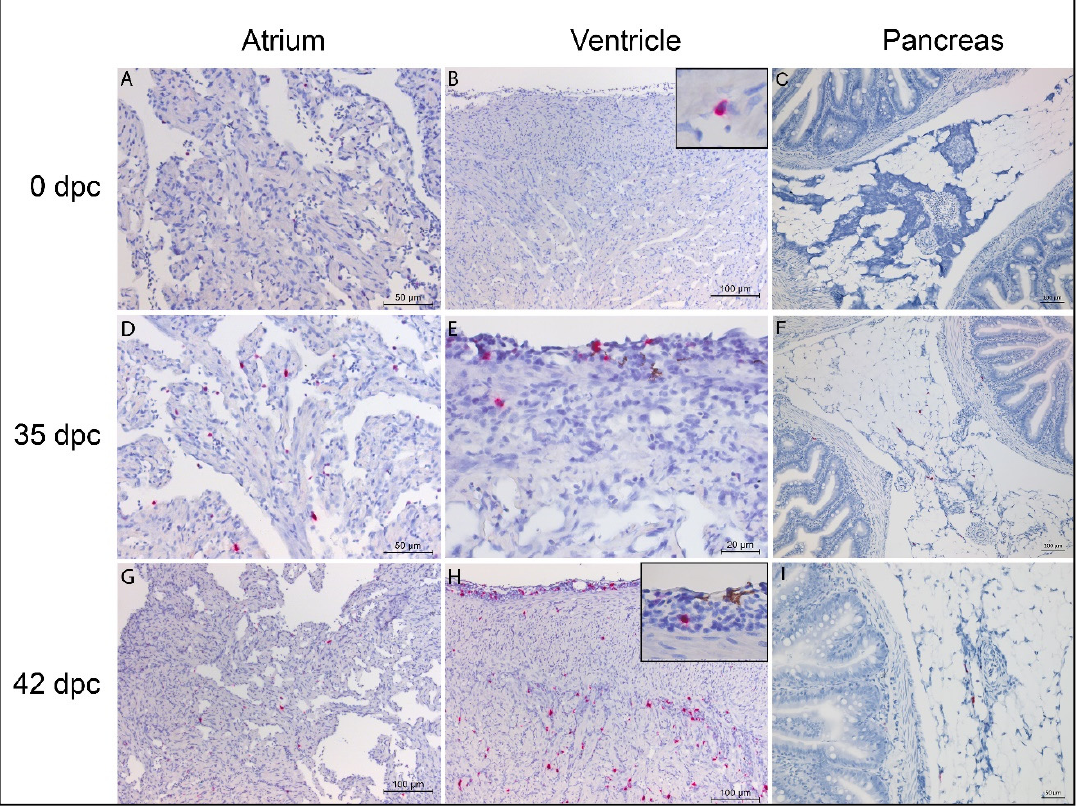
Figure 2. In situ hybridization of IgT transcripts in SAV-naïve Atlantic salmon at 0, 35, and 42 days post-SAV challenge (dpc). Images are taken from representative individuals within each group. ( A – C ) Few scattered IgT-positive cells evident in the atrium, ventricle, and pancreas at 0 dpc. ( D – F ) Presence of IgT-positive cells in all tissues evident at 35 dpc. ( G – I ) IgT-positive cell infiltrates mainly seen in the stratum spongiosum and in the transition zone between the stratum compactum and the stratum spongiosum at 42 dpc. Few scattered IgT-positive cells evident in the atrium and